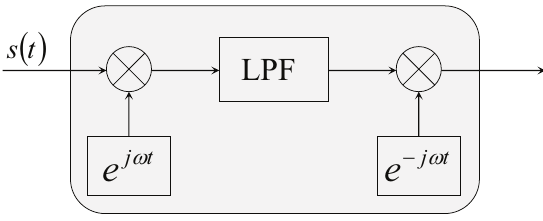
Figure 16. The schematic diagram of the canonical high Q bandpass